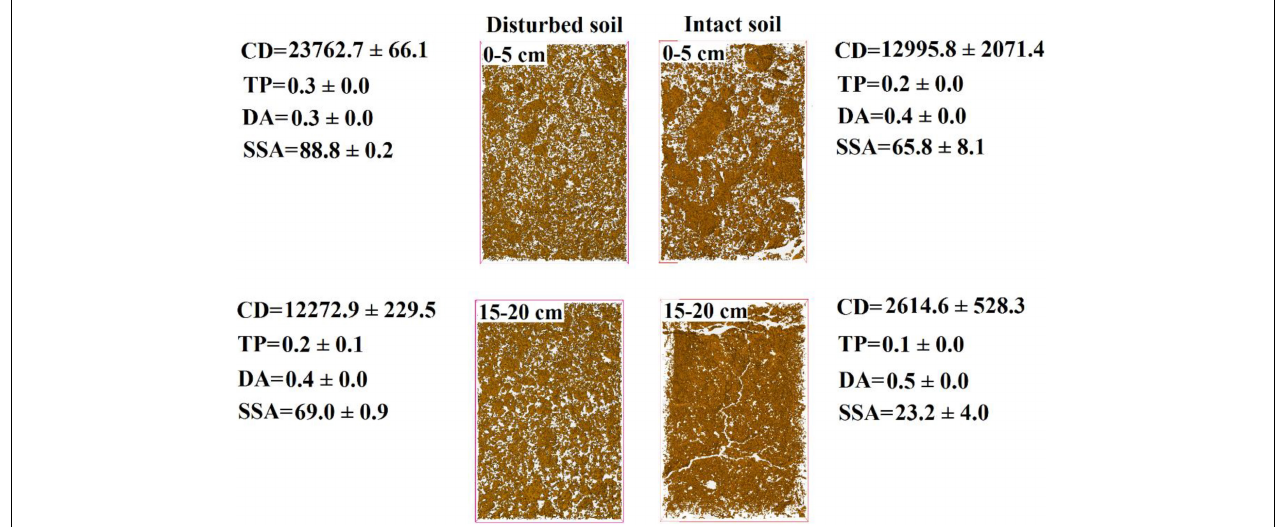
FIGURE 3 | Computed tomography (CT) images of disturbed and intact soil cores at soil depths of 0–5 cm and 15–20 cm. CD is connectivity density of pores (cm − 3 ), TP is total porosity (%), DA is degree of anisotropy, SSA is specific surface area (cm 2 cm − 3 ), and the white areas represent soil pore network.